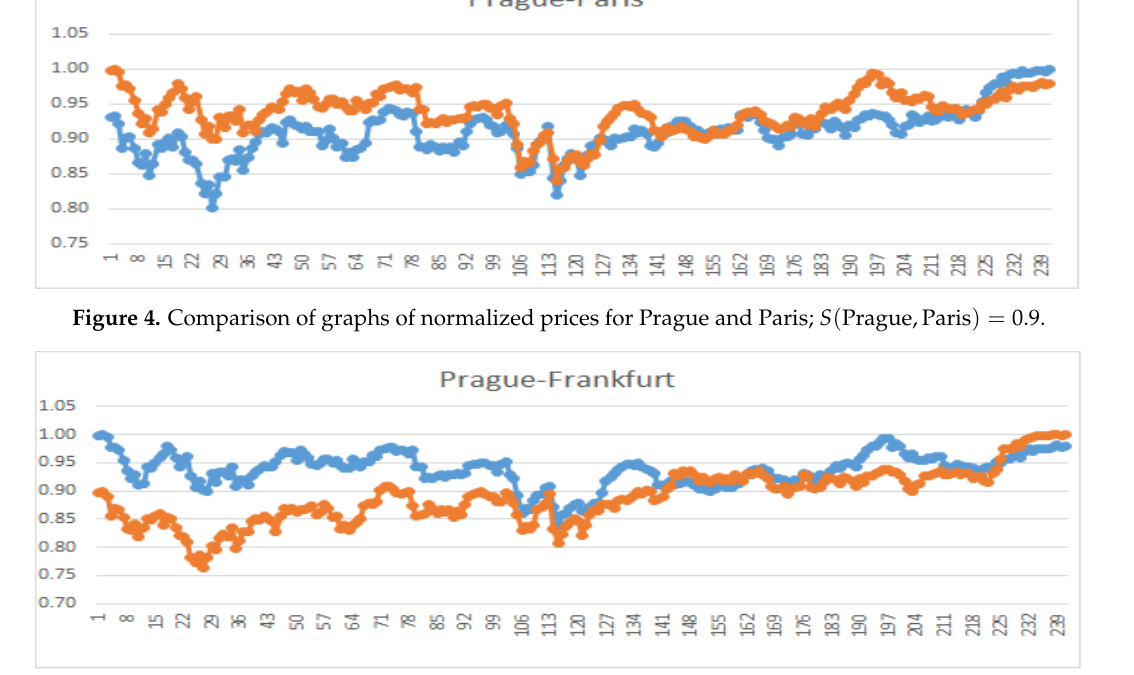
Figure 5. Comparison of graphs of normalized prices for Frankfurt and Prague; S ( Prague,Frankfurt ) = 0.84.